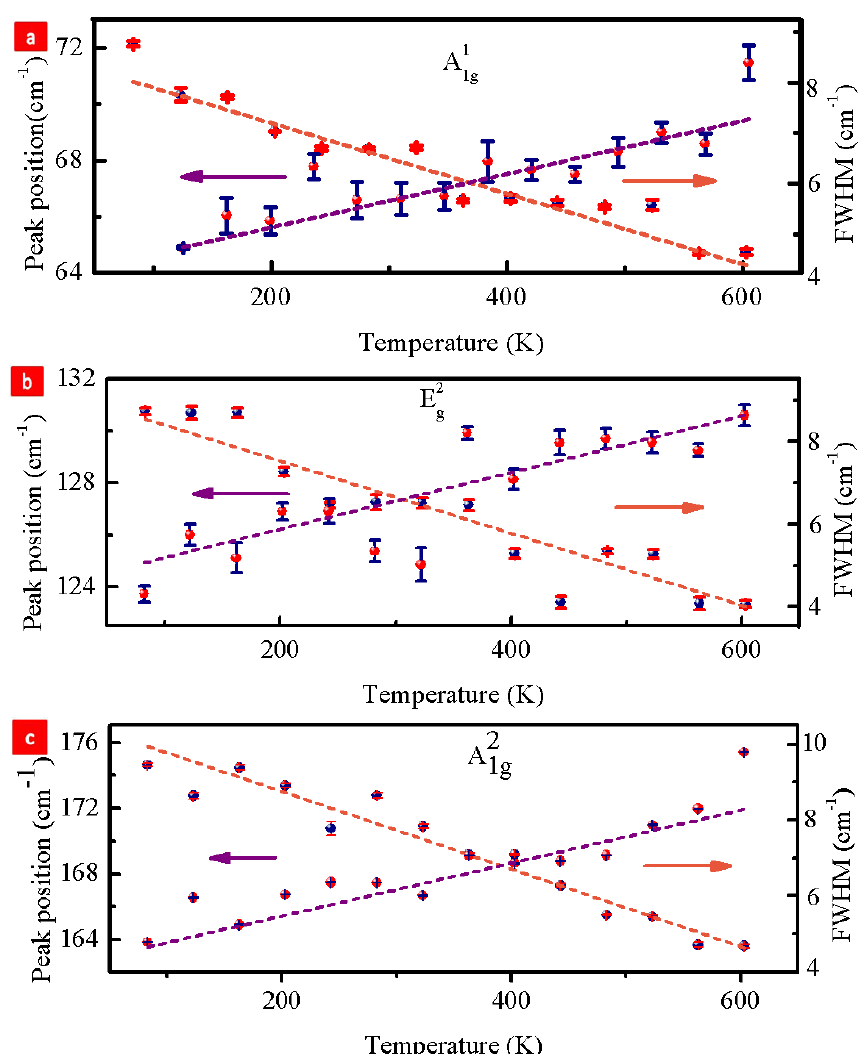
Figure 4. The peak position and temperature (K), FWHM and temperature (K), the peak position and